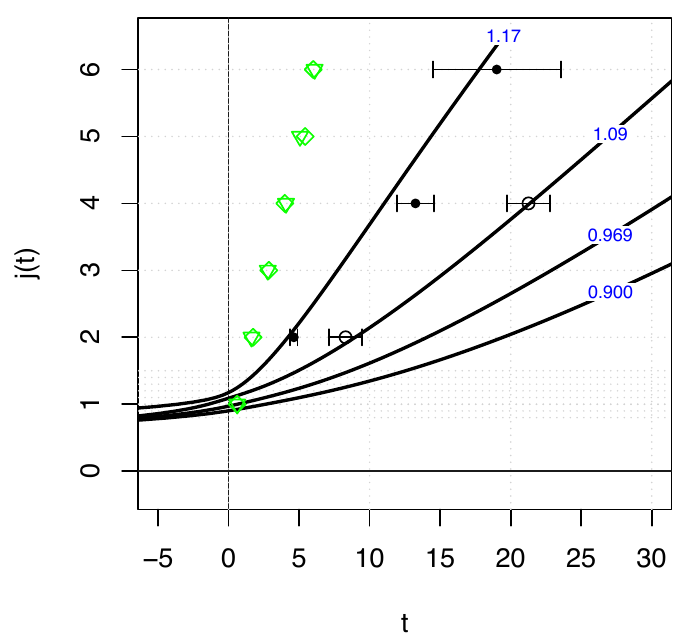
Figure 3 . The (cid:12)rst four pomeron trajectories found in this paper. The blue labels are the intercepts of each one. Shown are also the masses of the higher spin glueballs from lattice QCD data [46, 47], which clearly seem to belong to the hard and soft pomeron trajectories. In green we plotted the masses of vector mesons, which also contribute to DIS, but are expected to have a lower intercept than the (cid:12)rst pomeron trajectories considered in this